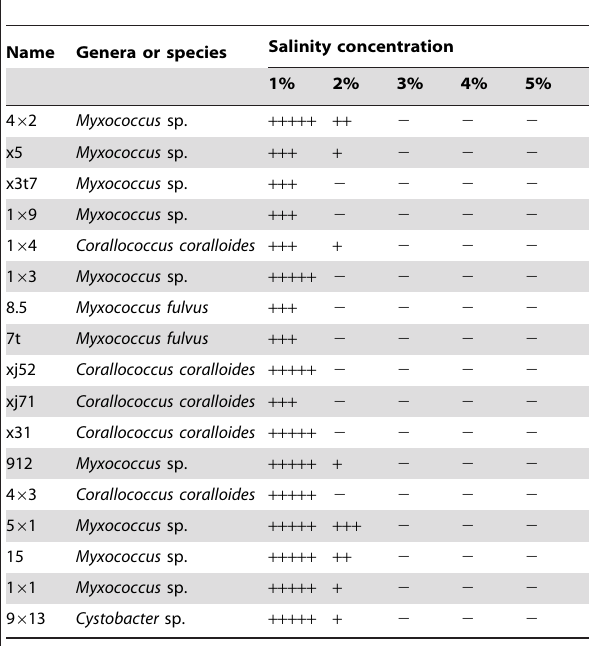
Table 8. Growth of some of myxobacteria at different NaCl